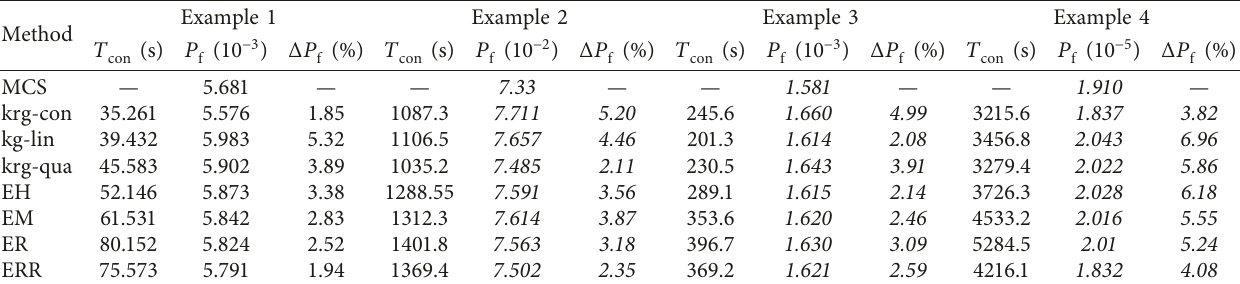
Table 5: Results of the reliability analysis of all numerical examples. Example 1 Example Method